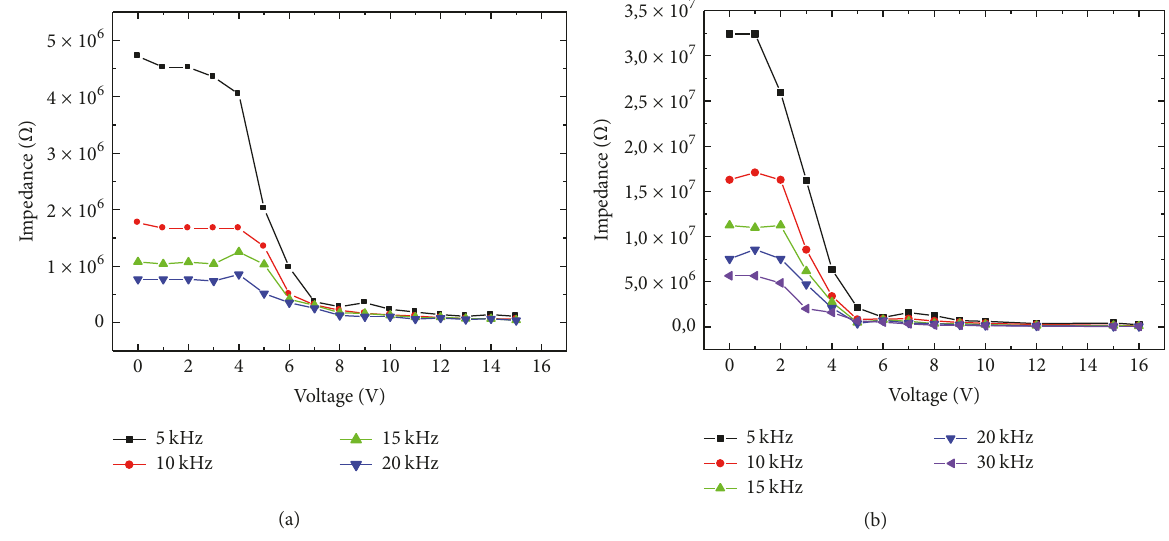
Figure 5: Impedance of the diode structure at different frequencies at direct (a) and reverse (b) bias ( e : 5 kHz, 󳵳 : 10kHz, 󳶃 : 15 kHz, ◼ : 20 kHz, 󳶣 : 30 kHz).